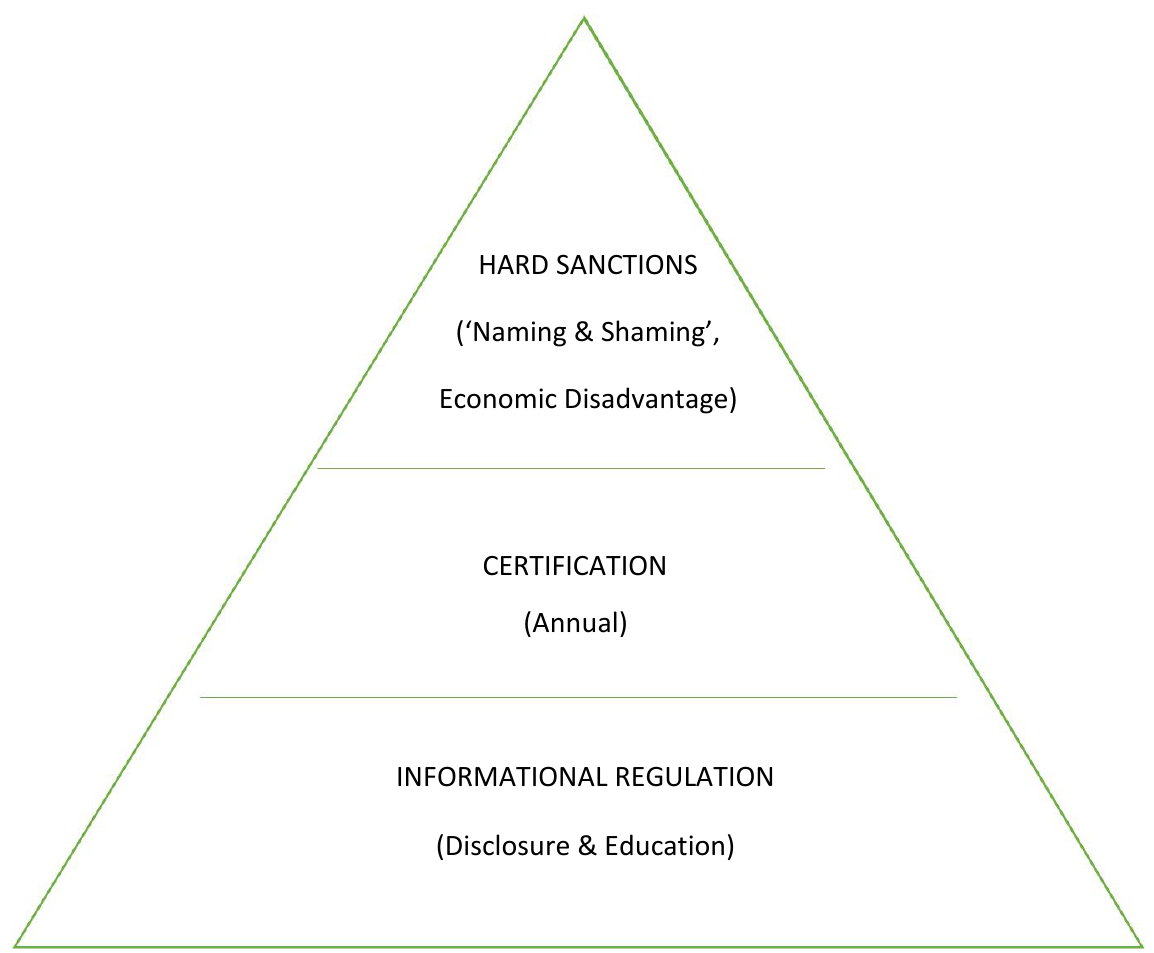
Figure 1 Regulation under the